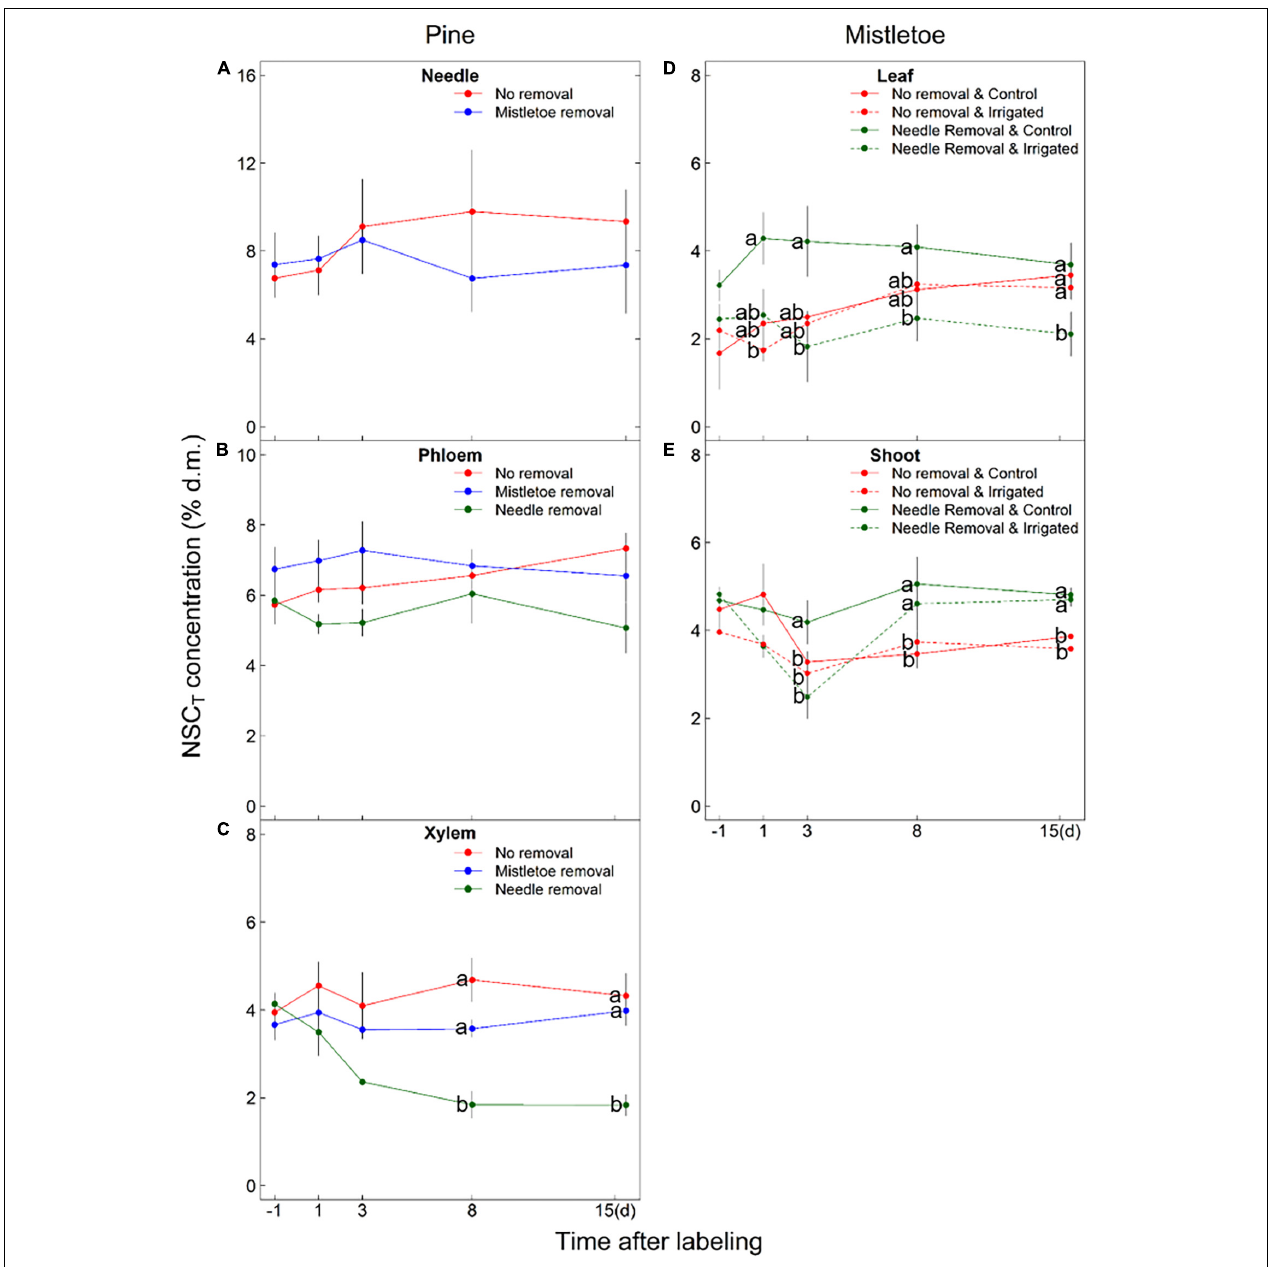
FIGURE 5 | NSC T concentration [% of dry matter (d.m.)] in different pine ( Pinus sylvestris ) (A–C) and mistletoe ( Viscum album ssp. austriacum ) (D,E) tissues under different removal treatments (i.e., pine needle removal for pine phloem and xylem, mistletoe leaf and shoot; mistletoe removal for pine needle, phloem and xylem) applied to the girdled branches. The initial samples were collected 1 day before the labeling. Dashed lines (D,E) are used to indicate where the irrigation treatment had significant effect ( P < 0.05) on NSC T concentration (see Table 2 ). Different letters indicate significant differences among treatments at the same sampling time ( n = 3). Please note the difference in y- axis scale among